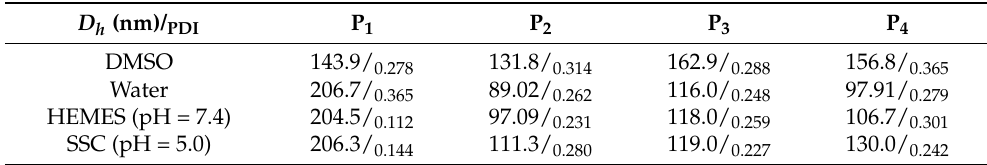
Table 2. Summary of the mean sizes and polydispersity indexes (PDIs) of the synthesized five amphiphilic bottlebrush copolymers, P 1 – P 4 , determined by DLS in water, DMSO, and HEPES (10 mM, pH 7.4) at a polymer concentration of 0.5 mg/mL.